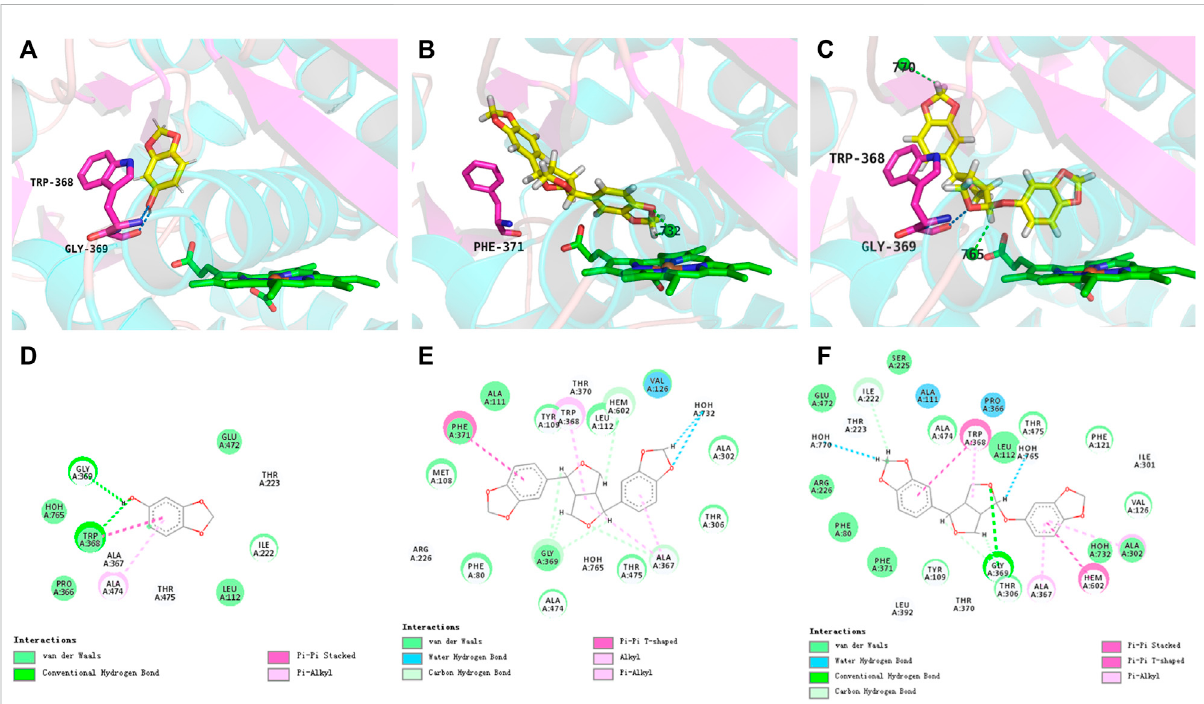
FIGURE 5 Views of the CYP46A1 active site illustrating interactions with sesamol (A) , sesamin (B) , and sesamolin (C) . The heme iron and water molecules (W770, W765, and W732) are represented by brown and green spheres, respectively. Dashed blue and green lines indicate conventional hydrogen bonds and water-hydrogen bonds, respectively. The interacting 2D plots of sesamol (D) , sesamin (E) , and sesamolin (F) located within the active site of CYP46A1.